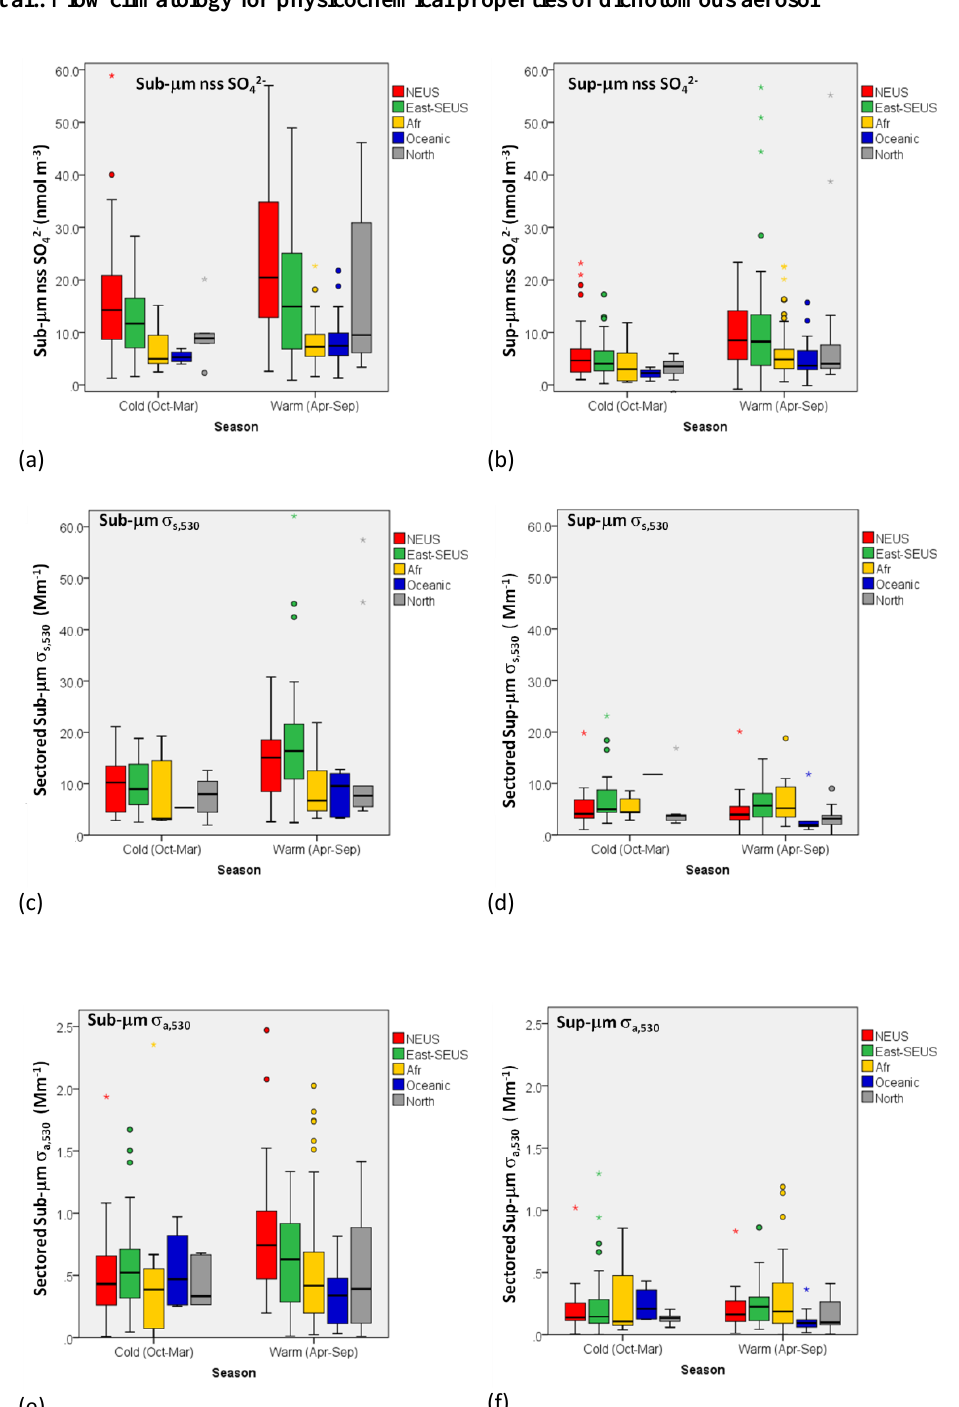
Fig. 4. Box and whisker plots (as described in Fig. 3) for (a) sub-µm nss SO 2 − (d) sectored super-µm σ s, 530 , (e) sectored sub-µm σ a , 530 , and (d) sectored super-µm σ a , 530 associated with each of the source region flow patterns by